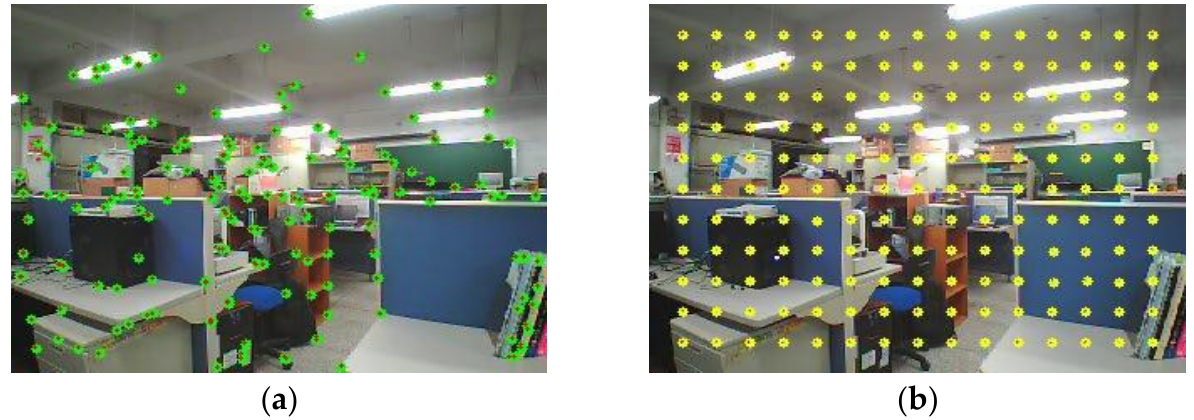
Figure 1. Comparison of point distribution for evaluating optical flow. ( a ) Harris corner points selection; ( b ) uniformly distribute points.